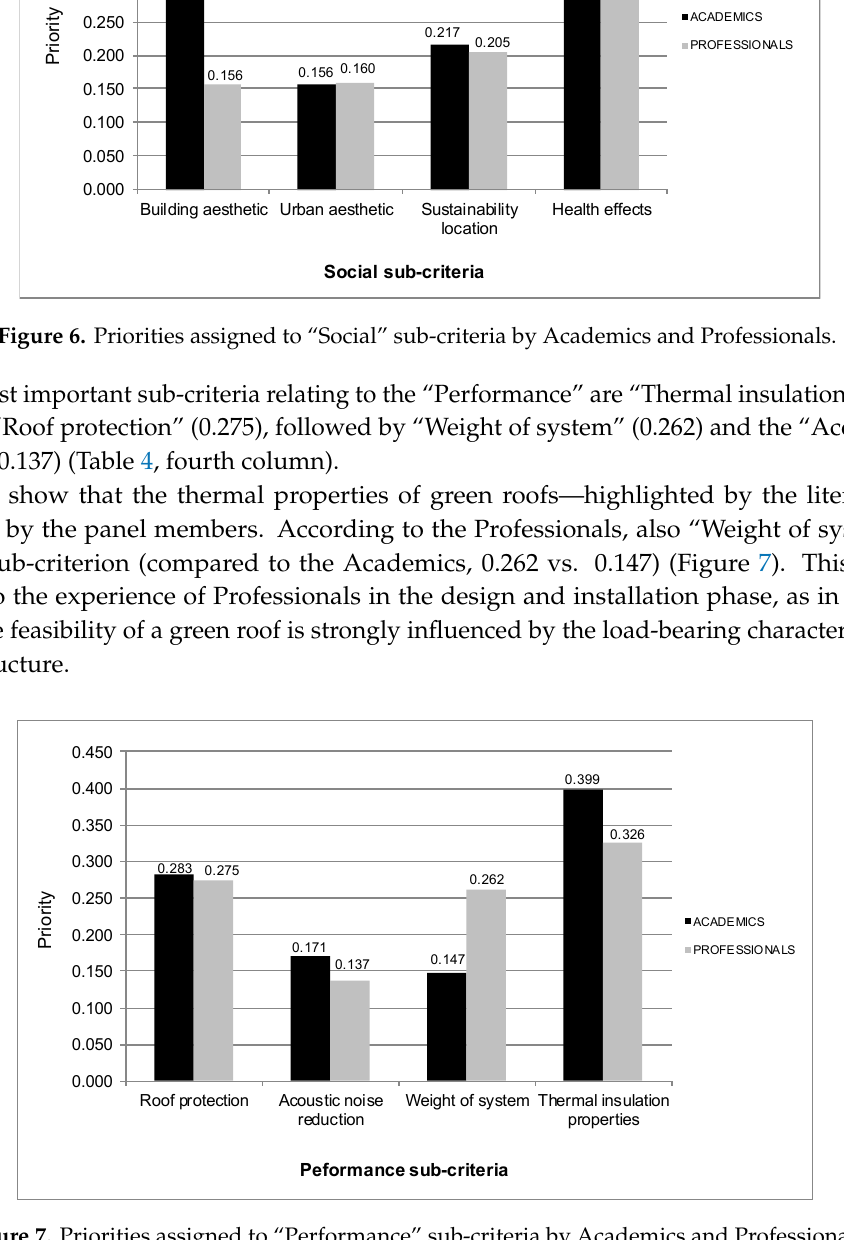
Figure 7. Priorities assigned to “Performance” sub-criteria by Academics and Professionals.